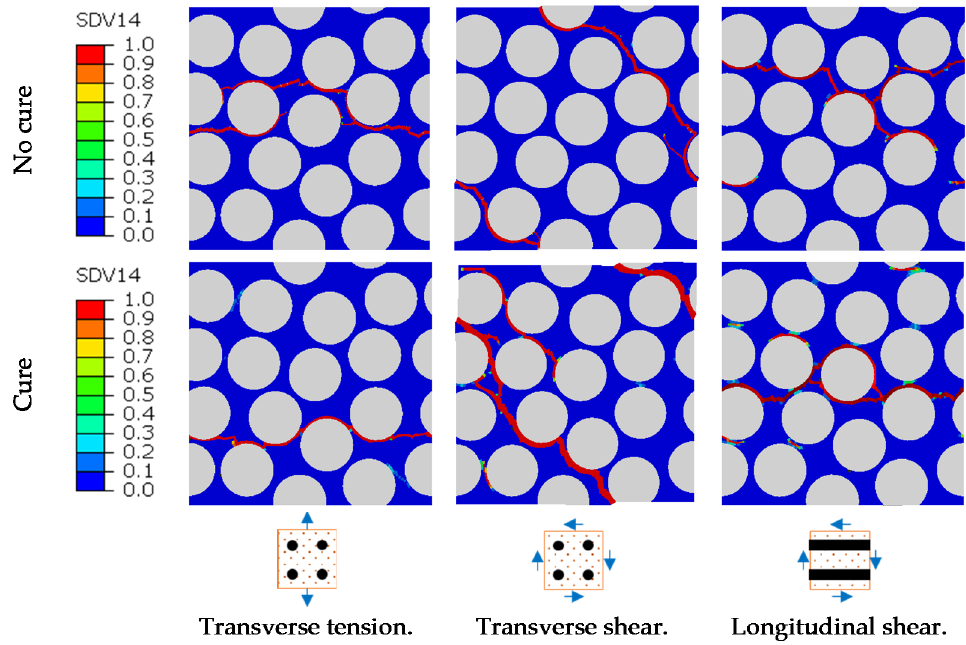
Figure 15. Damage patterns at failure for the different loading cases (SDV14 refers to the damage state variable).